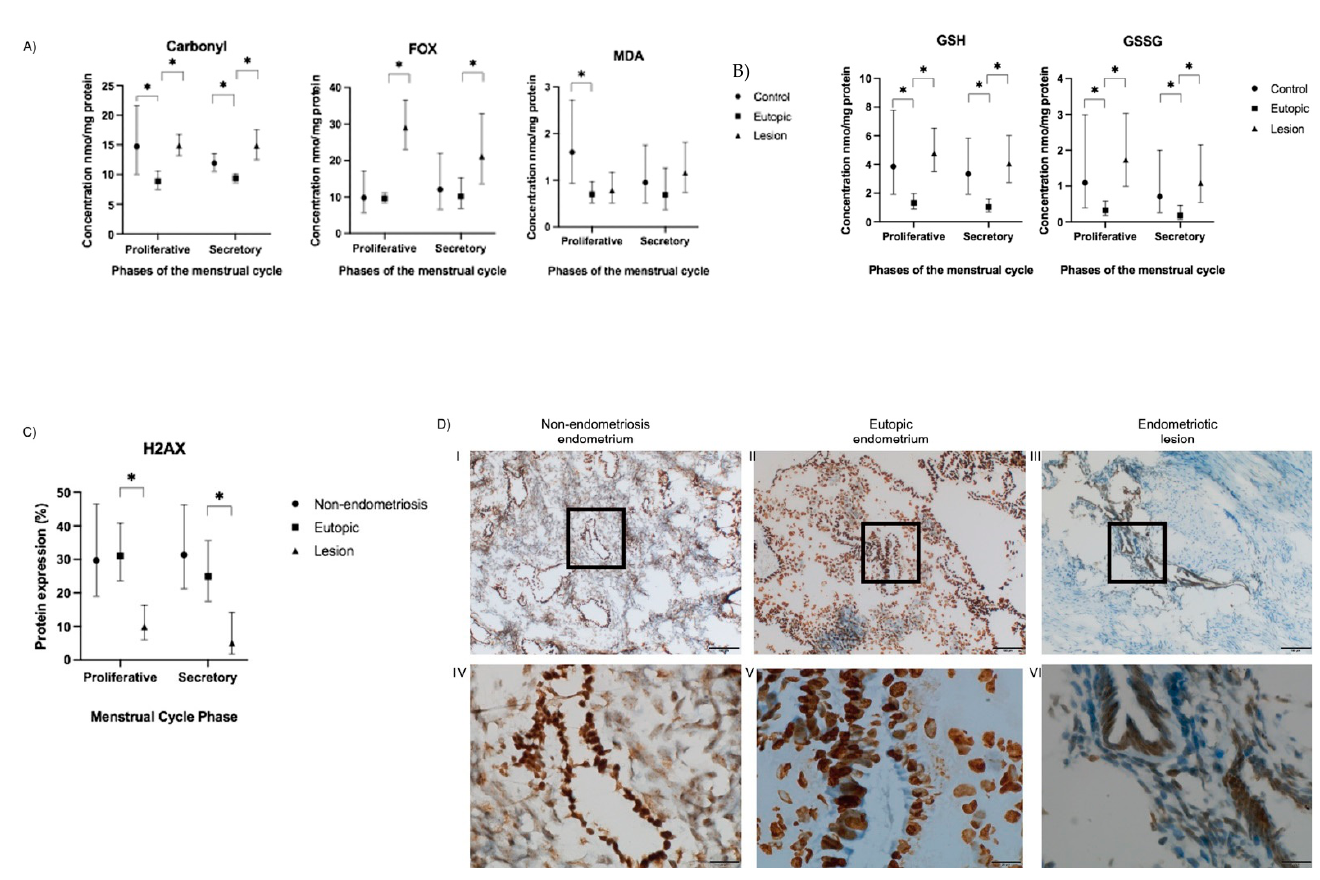
Figure 1. Oxidative stress markers (FOX, MDA, carbonyl, GSH, GSSG, and H2A.X) in tissue samples (lesion, eutopic endometrium, and non-endometriosis control) and in different menstrual cycle phases (secretory and proliferative phase) of patients with and without endometriosis. Data are expressed as estimated mean values and 95% confidence intervals. Concentration of ( A ) carbonyl; FOX; MDA; ( B ) GSH; GSSG; and ( C ) H2A.X. ( D ) Images of H2A.X protein labeling in endometriosis tissues and controls. Brown represents staining by the H2A.X antibody, and blue marks the cell nuclei; the blank spaces were not considered in the quantitative analyses. Scale bar: ( I – III ) 100 µm; ( IV – VI ) 20 µm. * p < 0.05. MDA: malondialdehyde; FOX: ferric-orange xylenol, GSH: reduced glutathione; GSSG: oxidized glutathione; and H2A.X: histone H2A variant.